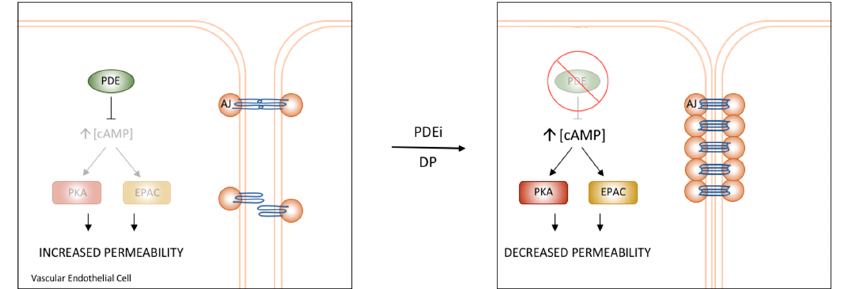
Figure 3. PDE regulation of Vascular Endothelial Permeability. PDE4D has been shown to regulate the permeability of the vascular endothelium through interactions with components of AJs. Treatment with PDE inhibitors or a specific disruptor of the PDE4D/EPAC1 interaction results in increased cAMP and stabilization of AJs, ultimately causing reduced permeability and increased barrier function